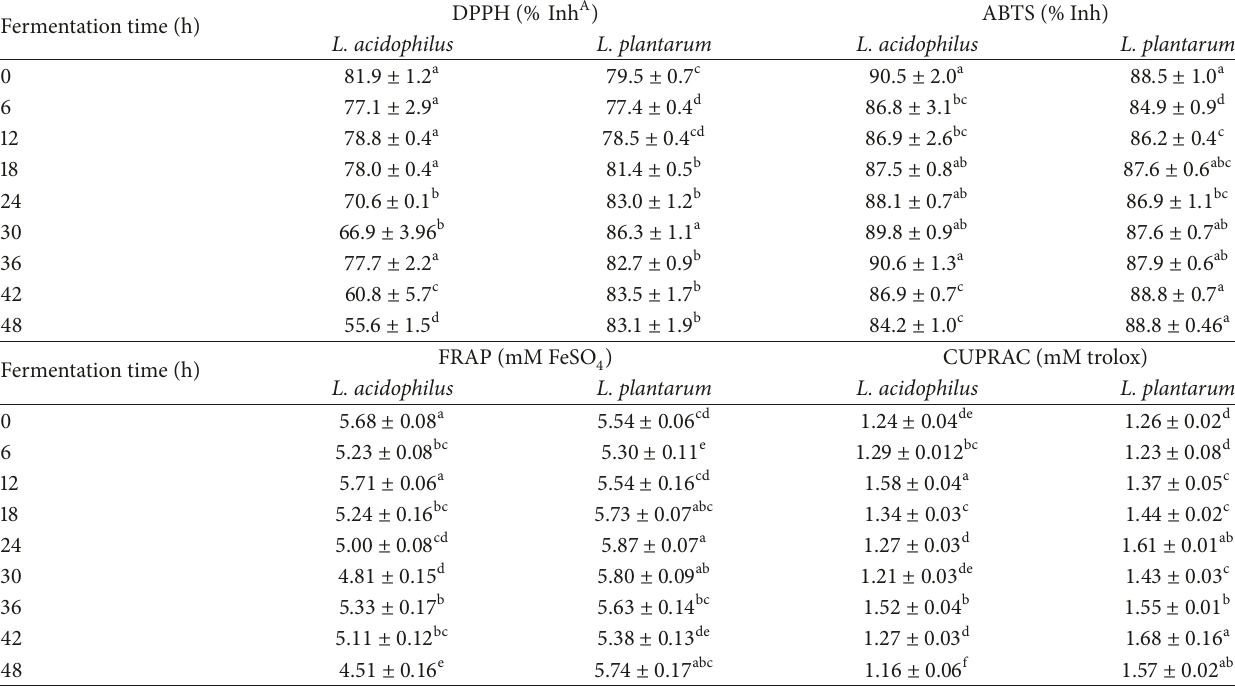
Table 3: Change in antioxidant activity of the fermented papaya juices.